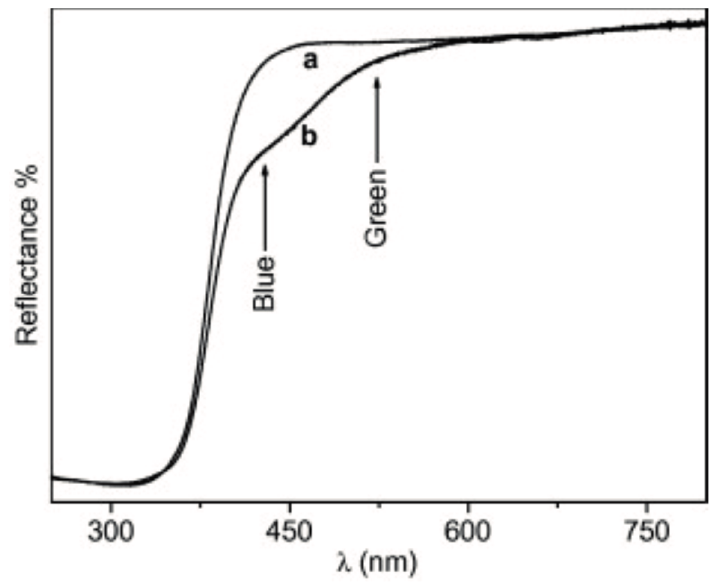
Figure 8. UV-visible reflectance spectra of (a) pristine TiO 2 (b) N-doped TiO 2 (reproduced from [126] with permission of